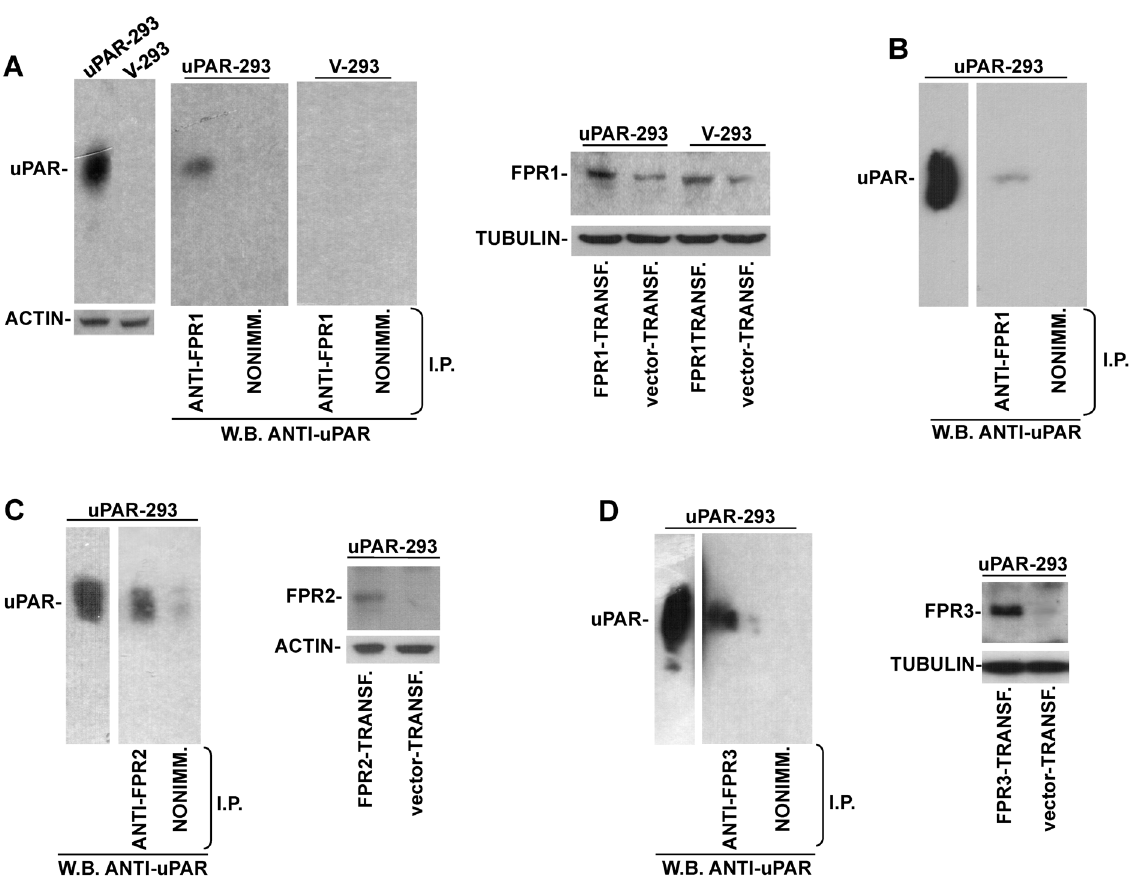
Figure 3. uPAR co-immunoprecipitates with fMLF-Rs. A: Lysates of uPAR-293 cells or V-293 cells, transiently transfected with FPR1 cDNA, were analyzed by Western blot with a uPAR-specific monoclonal antibody or immunoprecipitated with anti-FPR1 polyclonal antibodies or nonimmune rabbit immunoglobulins and then analyzed by Western blot with the uPAR-specific monoclonal antibody (left panels). Lysates of FPR1- or vector- transfected uPAR-293 and V-293 cells were analyzed by Western blot with a FPR1-specific polyclonal antibody to assess the levels of FPR1 expression (right panel). Tubulin or actin were detected for loading control. B: Lysates of uPAR-293 cells, not transfected with FPR1 cDNA, were analyzed by Western blot with a uPAR-specific monoclonal antibody or immunoprecipitated with anti-FPR1 polyclonal antibodies or nonimmune rabbit immunoglobulins and then analyzed by Western blot with a uPAR-specific monoclonal antibody. C: Lysates of uPAR-293 cells, transiently transfected with FPR2 cDNA, were analyzed by Western blot with anti-uPAR antibodies or immunoprecipitated with an anti-FPR2 monoclonal antibody or nonimmune mouse immunoglobulins and analyzed by Western blot with a uPAR-specific polyclonal antibody (left). Lysates of FPR2- or vector- transfected uPAR-293 cells were analyzed by Western blot with anti-FPR2 rabbit or anti-actin mouse antibodies (as loading control) to assess the levels of FPR2 expression (right). D: Lysates of uPAR-293 cells, transiently transfected with FPR3 cDNA, were analyzed by Western blot with anti-uPAR antibodies or immunoprecipitated with anti-FPR3 polyclonal antibodies or nonimmune rabbit immunoglobulins and analyzed by Western blot with the uPAR-specific monoclonal antibody (left). Lysates of FPR3- or vector- transfected uPAR-293 cells were analyzed by Western blot with anti-FPR3 rabbit or anti-tubulin mouse antibodies (as loading control) to assess the levels of FPR3 expression (right). the presence of protease inhibitors. The insoluble residue, enriched rabbit polyclonal antibody for FPR2 immunoprecipitates. Finally, in cytoskeleton-associated proteins, was solubilized in RIPA buffer washed filters were incubated with horseradish peroxidase- (150 mM NaCl, 50 mM Tris-HCl, pH 7.5, 1% deoxycholate, conjugated secondary antibodies and detected by ECL. 0.1% SDS, 1% Triton-X 100, and protease inhibitors) and preincubated with nonimmune serum and 10% protein A- Sepharose for 2 h at 4 u C. After centrifugation, the protein content of the supernatants was measured by a colorimetric assay (BIORAD) and 0.5 mg of protein was incubated for 2 h at 4 u C with 30 m g/ml of rabbit polyclonal antibodies against FPR1 or FPR3 or of a mouse monoclonal antibody directed to FPR2, or with 30 m g/ml of nonimmune rabbit or mouse immunoglobulins, as controls. After 30 min of incubation with 10% protein A- Sepharose at room temperature, the immunoprecipitates were washed, subjected to 10% SDS-PAGE, and analyzed by Western blot using 1 m g/ml of the R2 anti-uPAR monoclonal antibody for FPR1 and FPR3 immunoprecipitates, or 2 m g/ml of the 399